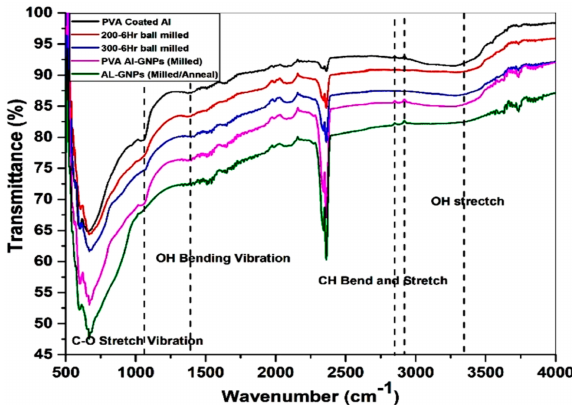
Figure 11. FTIR of the PVA coated Al; ball milled powders, PVA-Al/GNPs milled powder and after subsequent annealing.